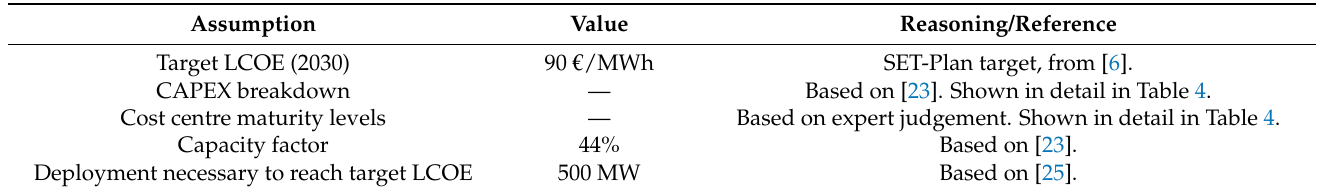
Table 3. Technology-specific assumptions used in floating offshore wind case study.